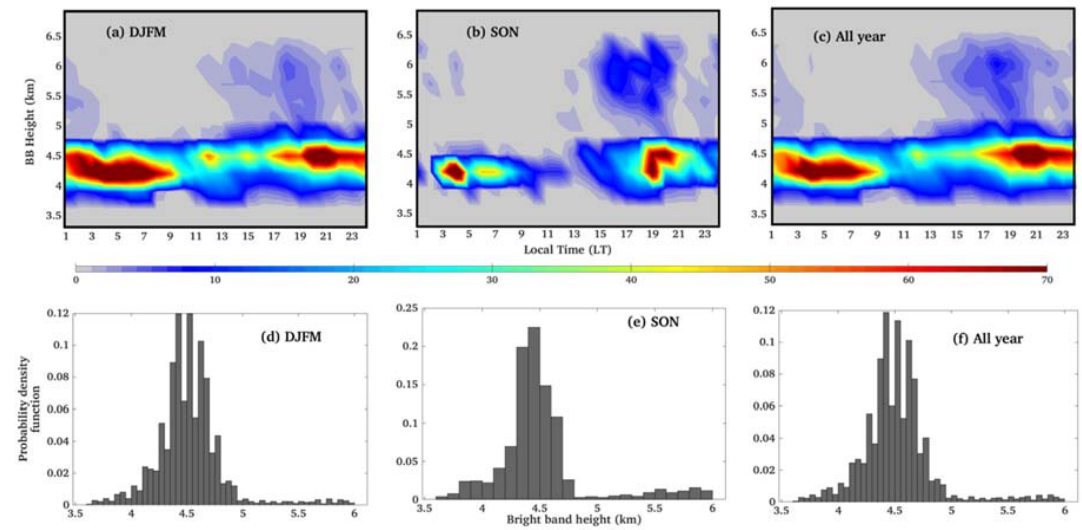
Figure 5. Time series of the bright band height for ( a ) December to March months (2015–2018), ( b ) for September to November months (2015–2018), ( c ) for 1 December 2015–31 December 2018. Probability density function (PDF) of bright band height for ( d ) December to March months (2015– 2018), ( e ) for September to November months (2015–2018), ( f ) for 1 December 2015–31 December 2018.